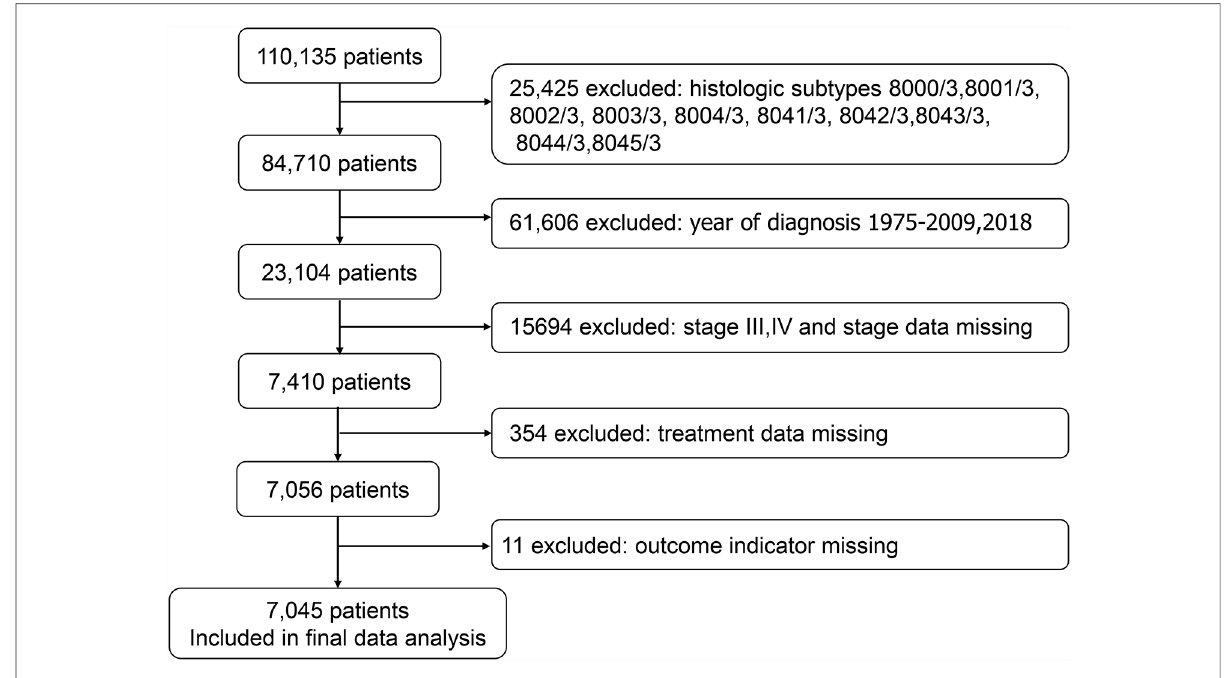
FIGURE 1 Flowchart used to screen the